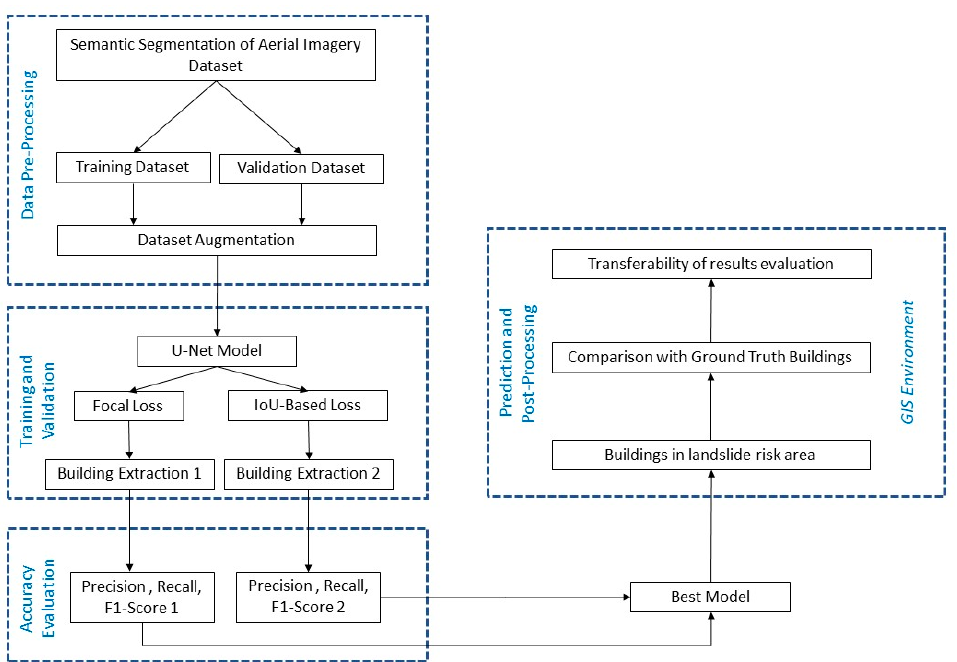
Figure 4. Methodology flow chart.